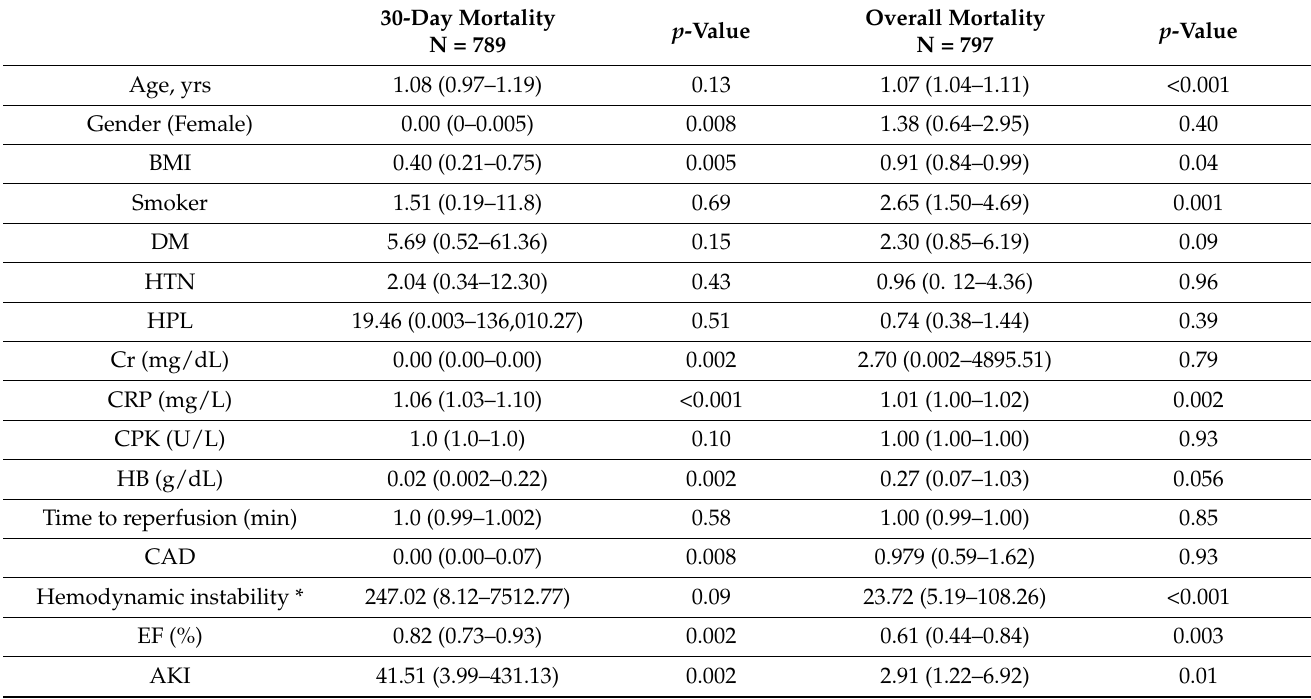
Table 4. Risk factors for mortality.